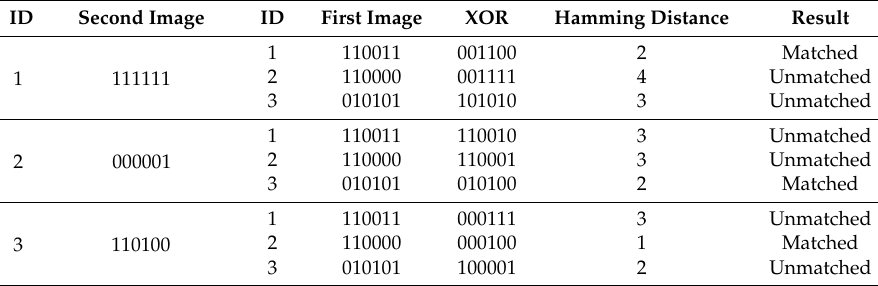
Table 1. Corner matching from two images (threshold = 3).